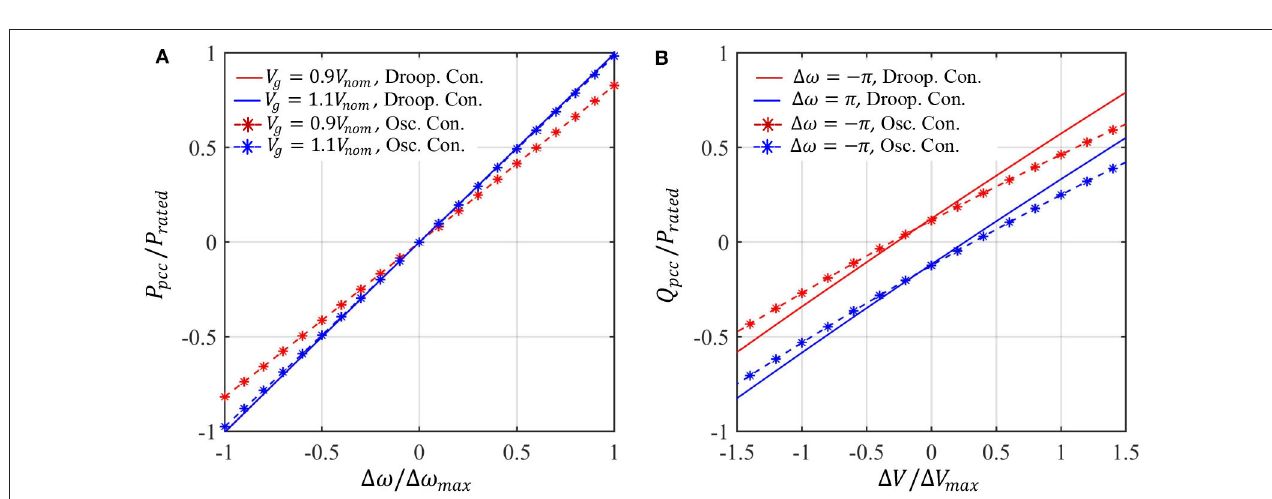
FIGURE 7 | Comparison of terminal behavior at the PCC: (A) real power vs. frequency, (B) reactive power vs. voltage.